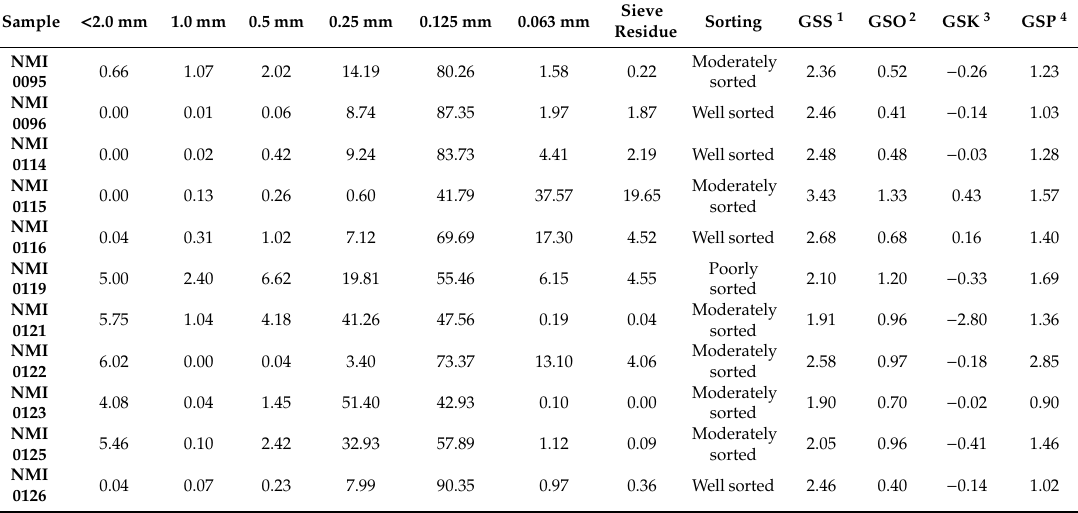
Table 2. Analysis of grain size and degree of sorting of beach sediment samples (in %). Statistic parameters ( φ method